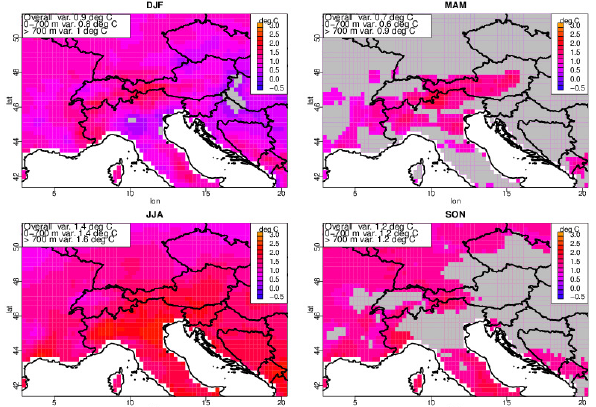
Figure 13: difference between the Multimodel SuperEnsemble scenario minimum temperatures averaged over the period 2031-2050 with respect to the period 1981-2000, as a function of the season (T-test conf. level 95%) in the GAR area. Fig. 13. Difference between the multimodel superensemble sce- nario minimum temperatures averaged over the period 2031–2050 with respect to the period 1981–2000, as a function of the season ( T test conf. level 95%) in the GAR area.